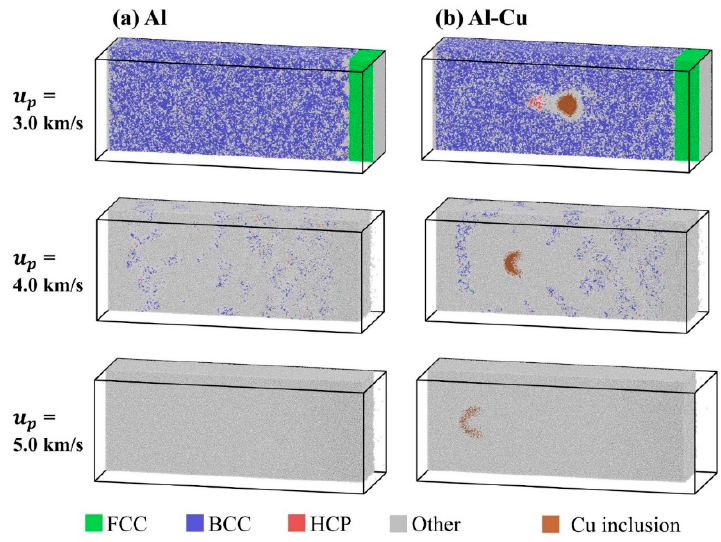
Figure 11. Atomic configurations during shock compression at 12 ps for different piston velocities as indicated on the left side. Al atoms are color coded by adaptive common neighbor analysis (a-CNA). ( a ) Ideal single crystal Al; ( b ) The crystal with Cu inclusion.